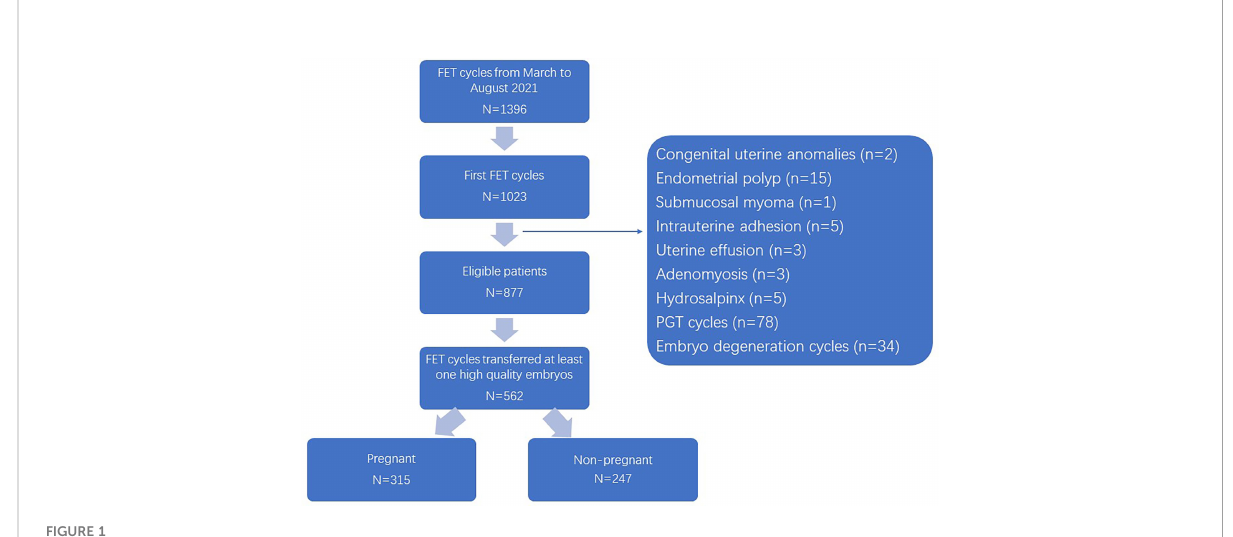
FIGURE 1 Flowchart of the included